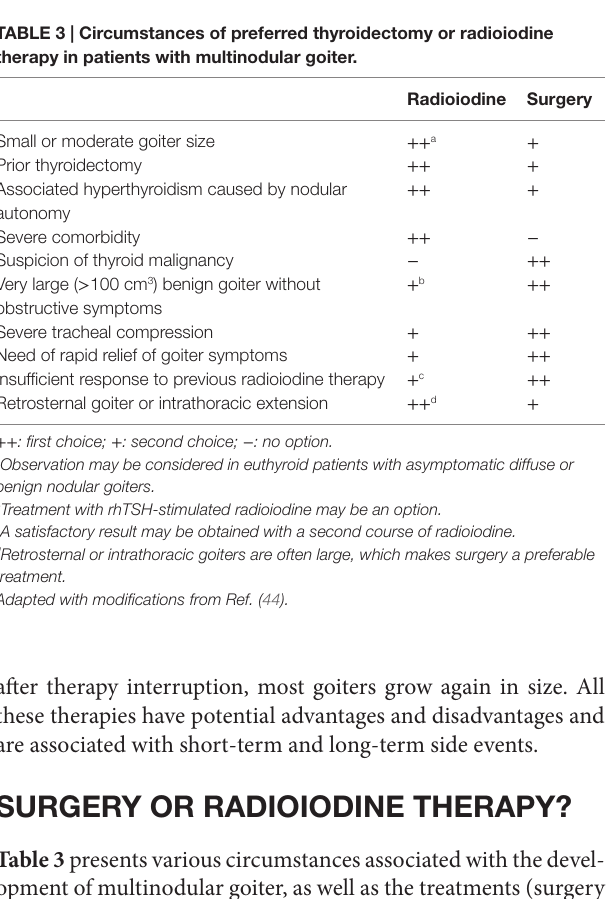
TABLe 3 | Circumstances of preferred thyroidectomy or radioiodine therapy in patients with multinodular goiter.